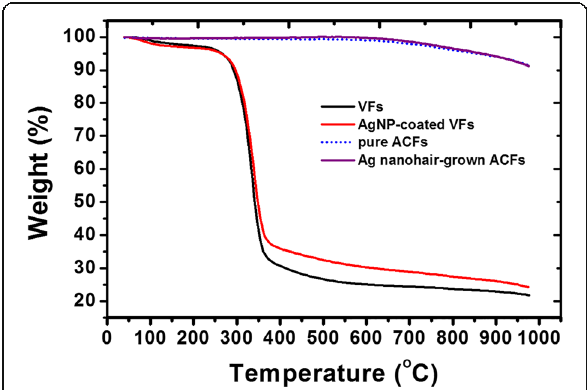
Fig. 8 Thermogravimetric curves of (black) pure VFs, (red) AgNP- coated VFs, (blue) pure ACFs, and (purple) Ag nanohair-grown ACFs